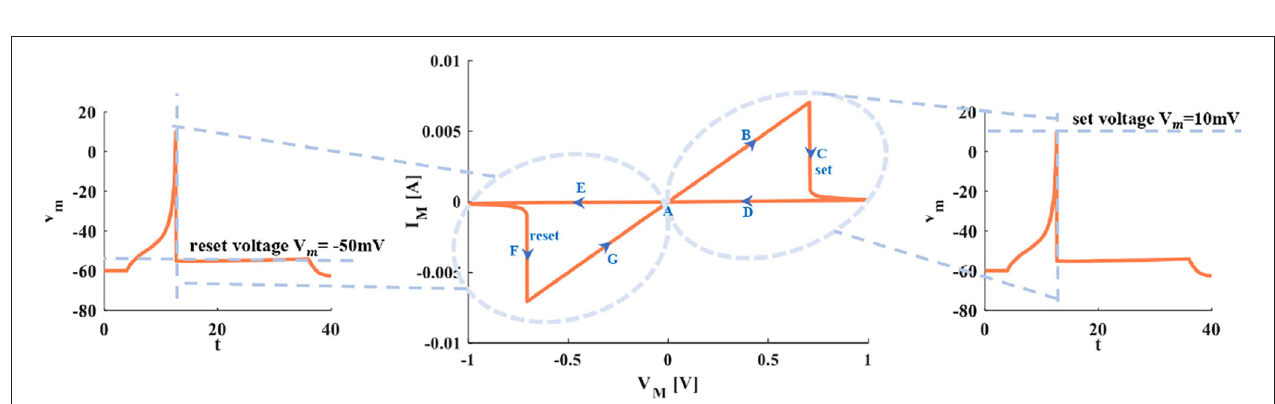
FIGURE 2 | The other three spiking patterns are generated by the IZH spiking model (The parameter values of the distinct spiking patterns: the all or none spiking pattern, a = 0.1, b = 0.26, c = − 60, d = 5; the excitation block spiking pattern, a = 0.02, b = 27.645, c = − 55, d = − 100; the refractory period spiking pattern, a = 0.1, b = 0.25, c = − 60, d = 5).